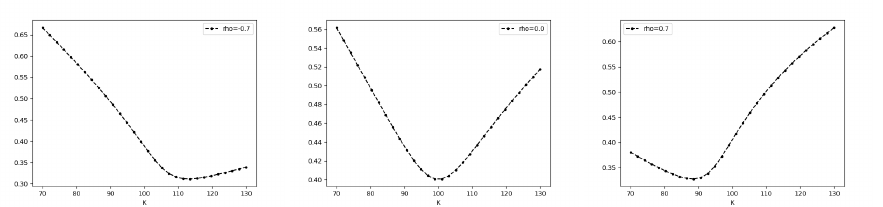
Figure 2. Simulated skews and smiles for a Heston model with σ 2 ν = 0.8, T = 0.1, and ρ = 0.7, 0, 0.7. − Moreover, skews and smiles are more pronounced for short maturities and they flatten as T increases (Figure 3).